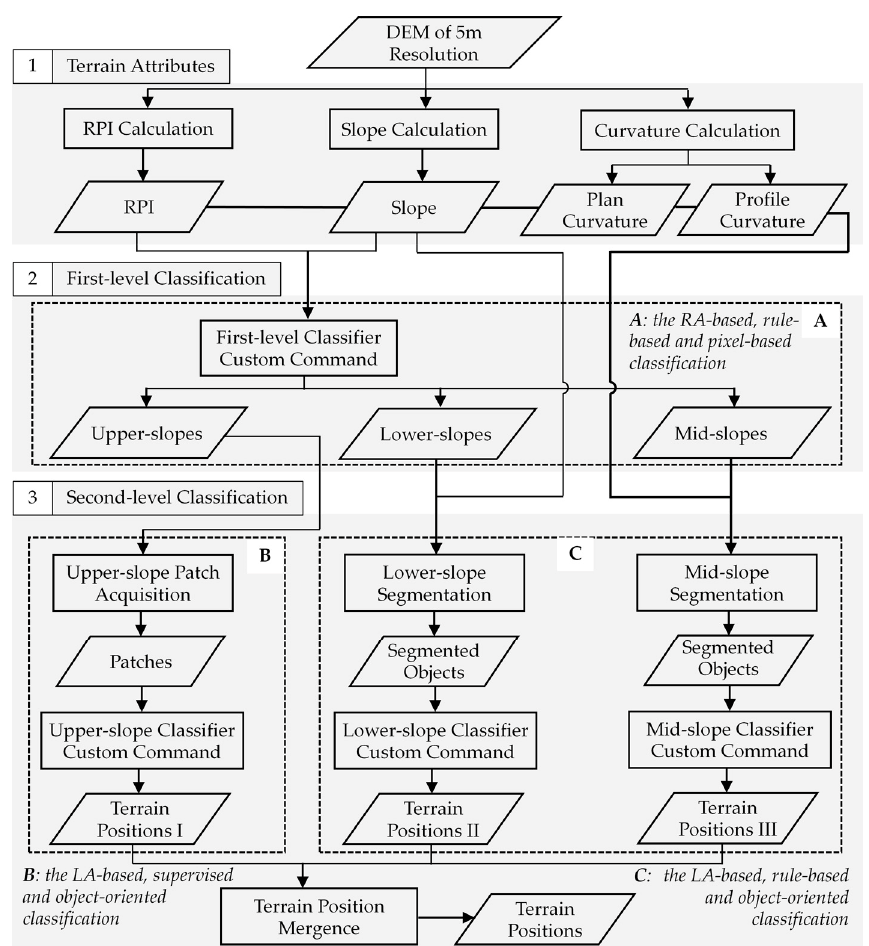
Figure 2. Flowchart of the proposed classification method.